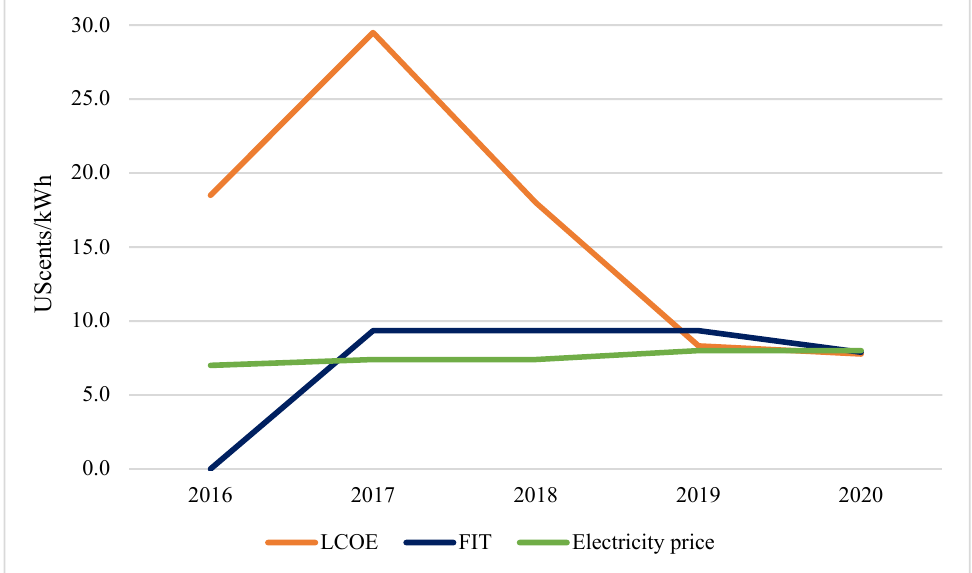
Figure 14. Electricity price and weighted-average LCOE and FIT of solar PV in Vietnam. (Adapted with permission from Refs. [9,10,36,37,85–87]. Copyright 2020/2021 International Renewable Energy Agency; Copyright 2017/2019 Vietnam Government; 2017/2019 Vietnam Ministry of Indus- try and Trade.